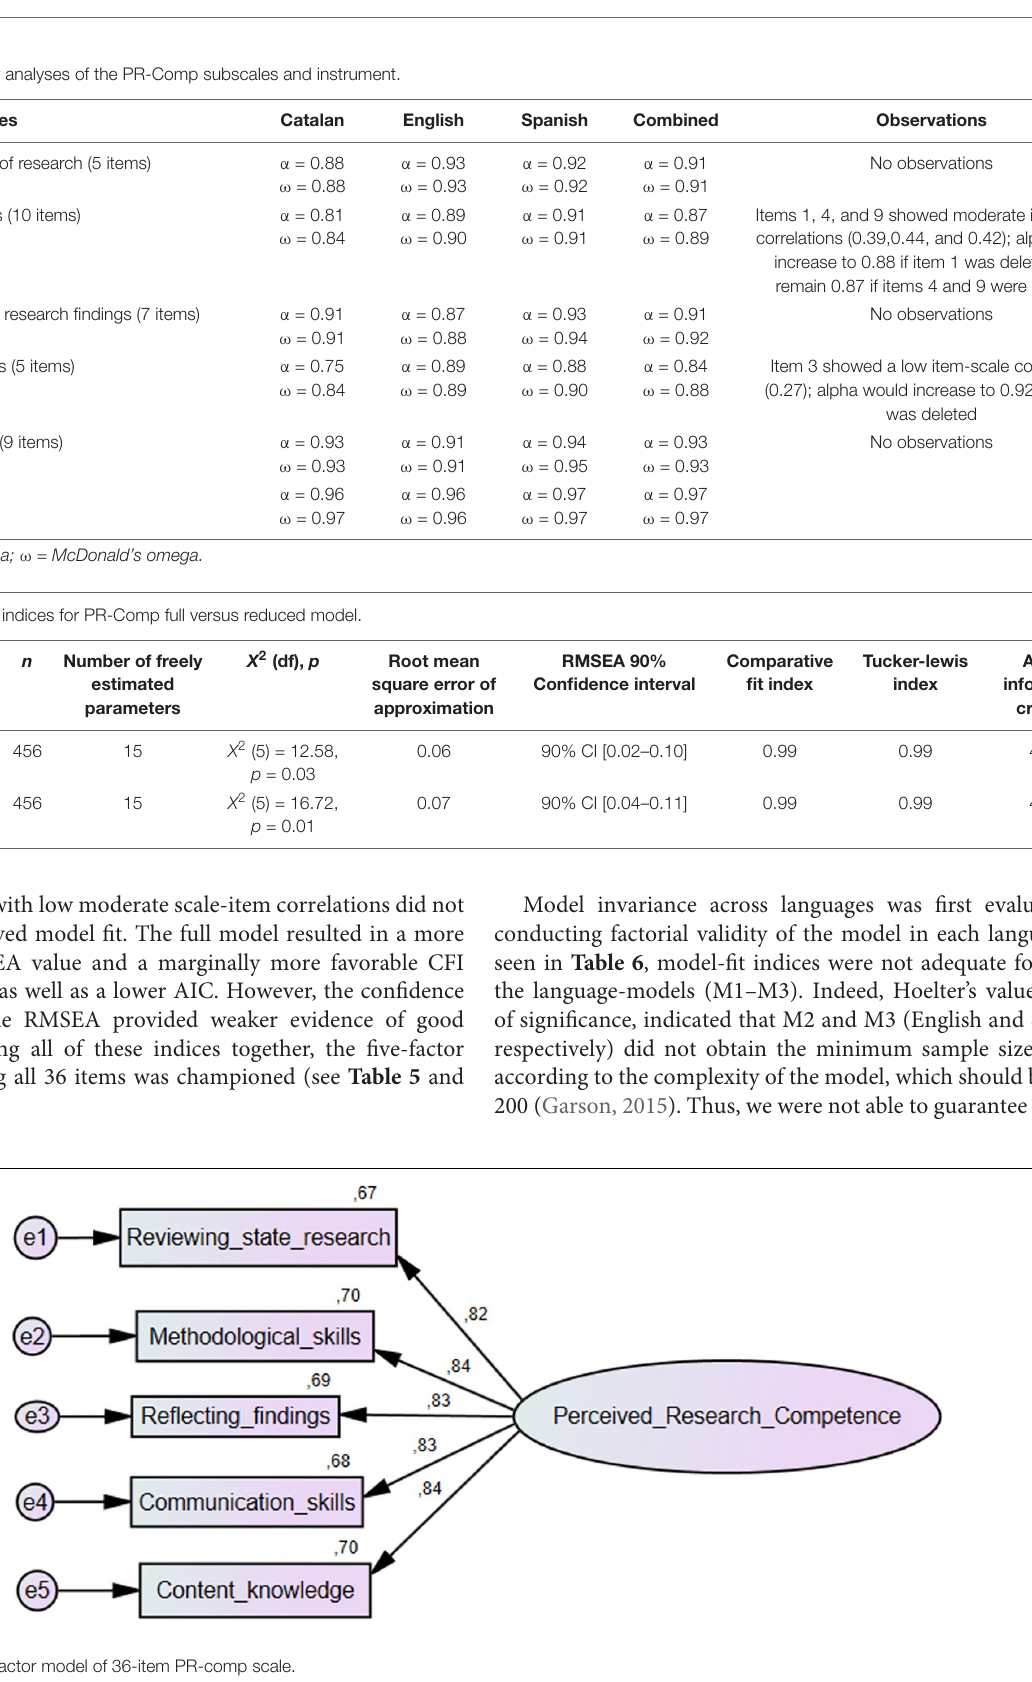
FIGURE 1 | Five-factor model of 36-item PR-comp